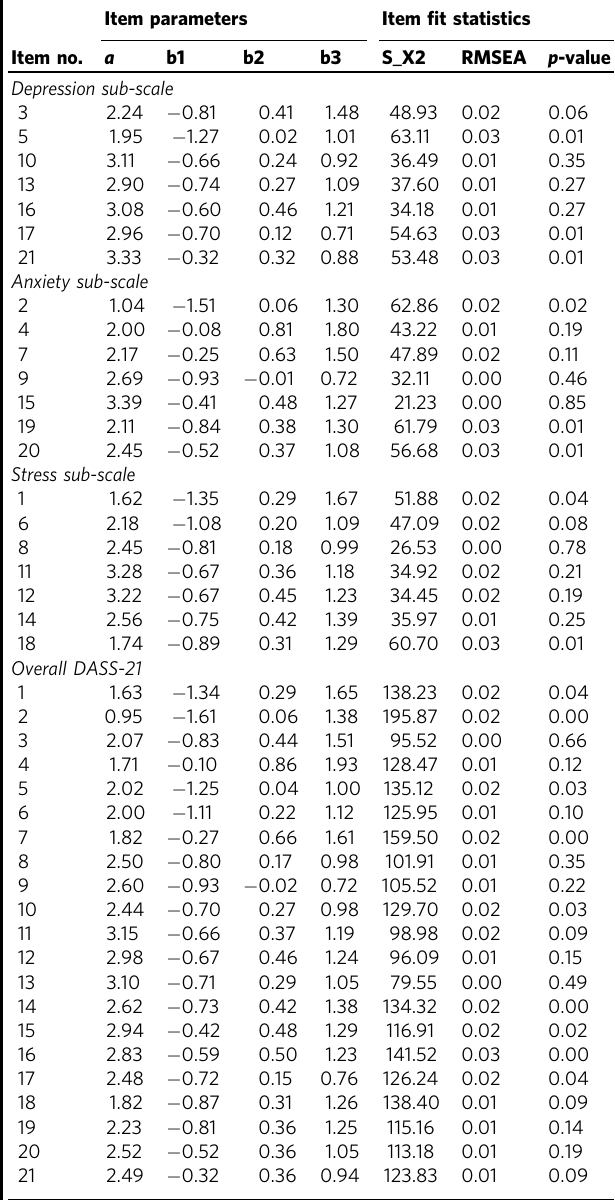
Table 3 Examining the dimensionality of DASS-21 scale and its sub-scales using con fi rmatory factor analysis.